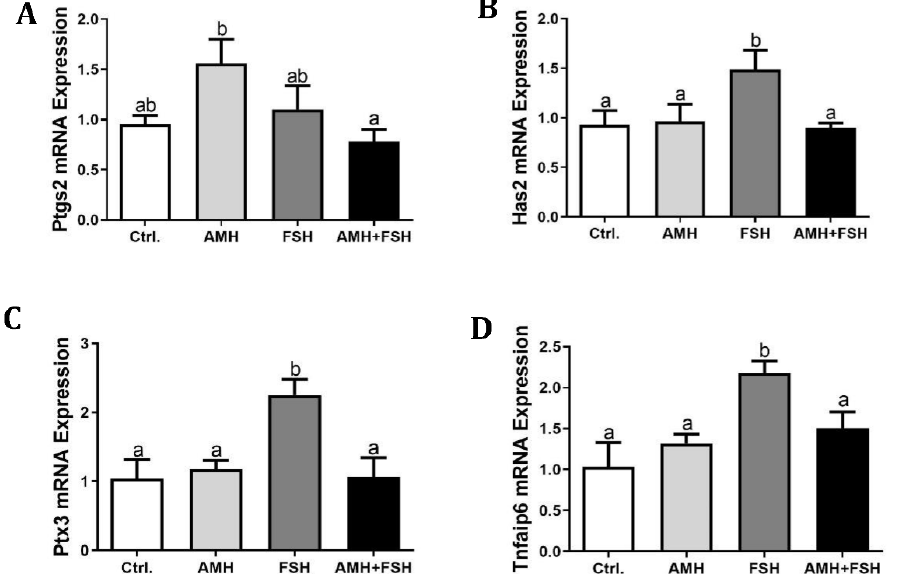
Figure 4. Effect of rhAMH on expression of cumulus expansion related genes. COCs were supple- mented with AMH and FSH alone or in combination for 16 h,relative expression of transcripts for Ptgs2 ( A ), Has2 ( B ), Ptx3 ( C ), and Tnfaip6 ( D ) genes in cumulus cells were detected by RT-qPCR. The results were evaluated as the relative ratio of the expression level of each mRNA to that of β -actin and were expressed as mean ± SEM from three independent experiments. Bars with different letters represent significant differences ( p <